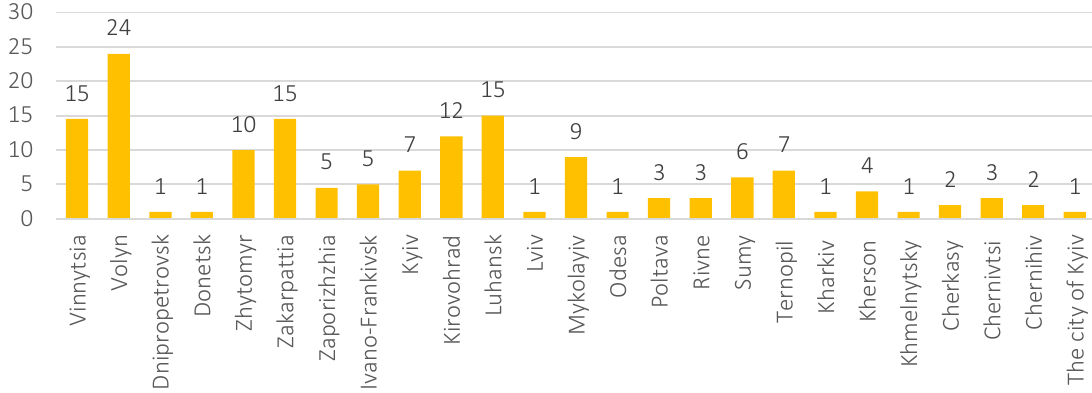
Figure 6. Positions of administrative-territorial units of Ukraine